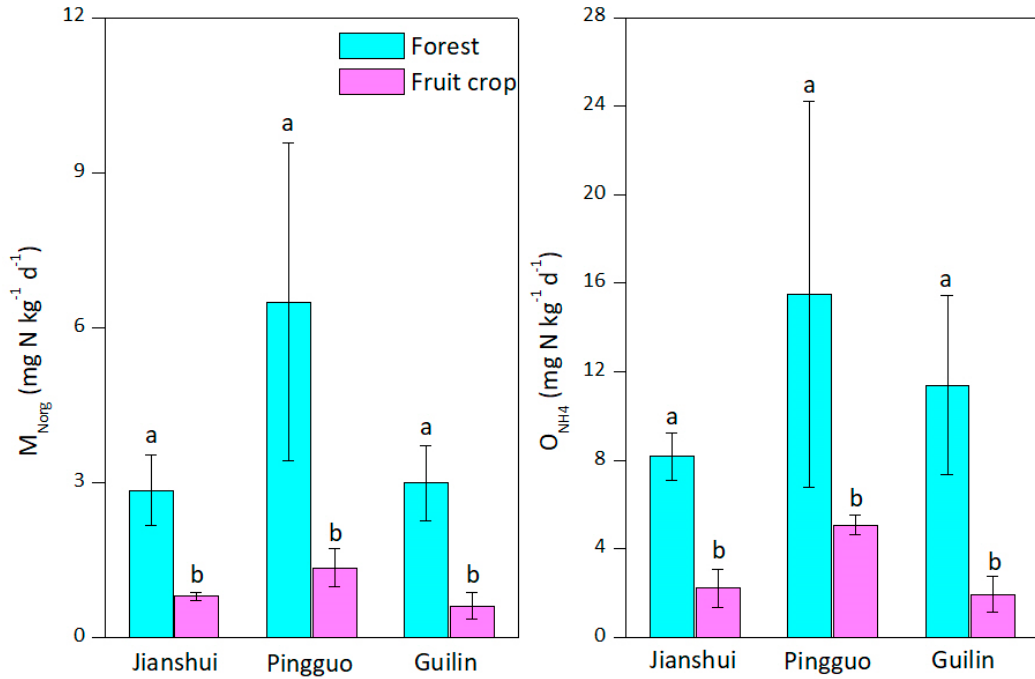
Figure 2. M Norg and O NH4 rates in soils sampled from Jianshui (forest vs. citrus), Pingguo (forest vs. pitaya), and Guilin (forest vs. Shatangju) regions. Different letters for M Norg or O NH4 indicate significant differences ( p < 0.05) between forest and fruit crop plantation in the same region. M Norg , the mineralization of organic N to NH 4+ ; O NH4 , the oxidation of NH 4+ to NO 3 − .